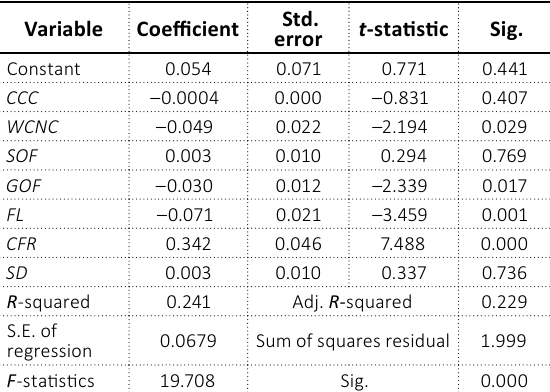
Table 5. Determinants of cash holding (CH)